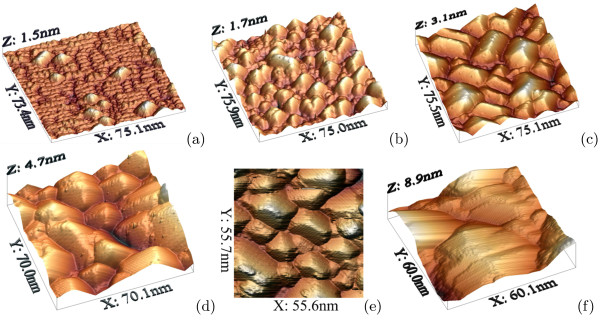
STM images of Ge/Si(001) quantum dot arrays grown at 360℃. hGe(Å) is (a) 6, (b) 8, (c) 10, (d) 14, (e) 15, (f) 18.